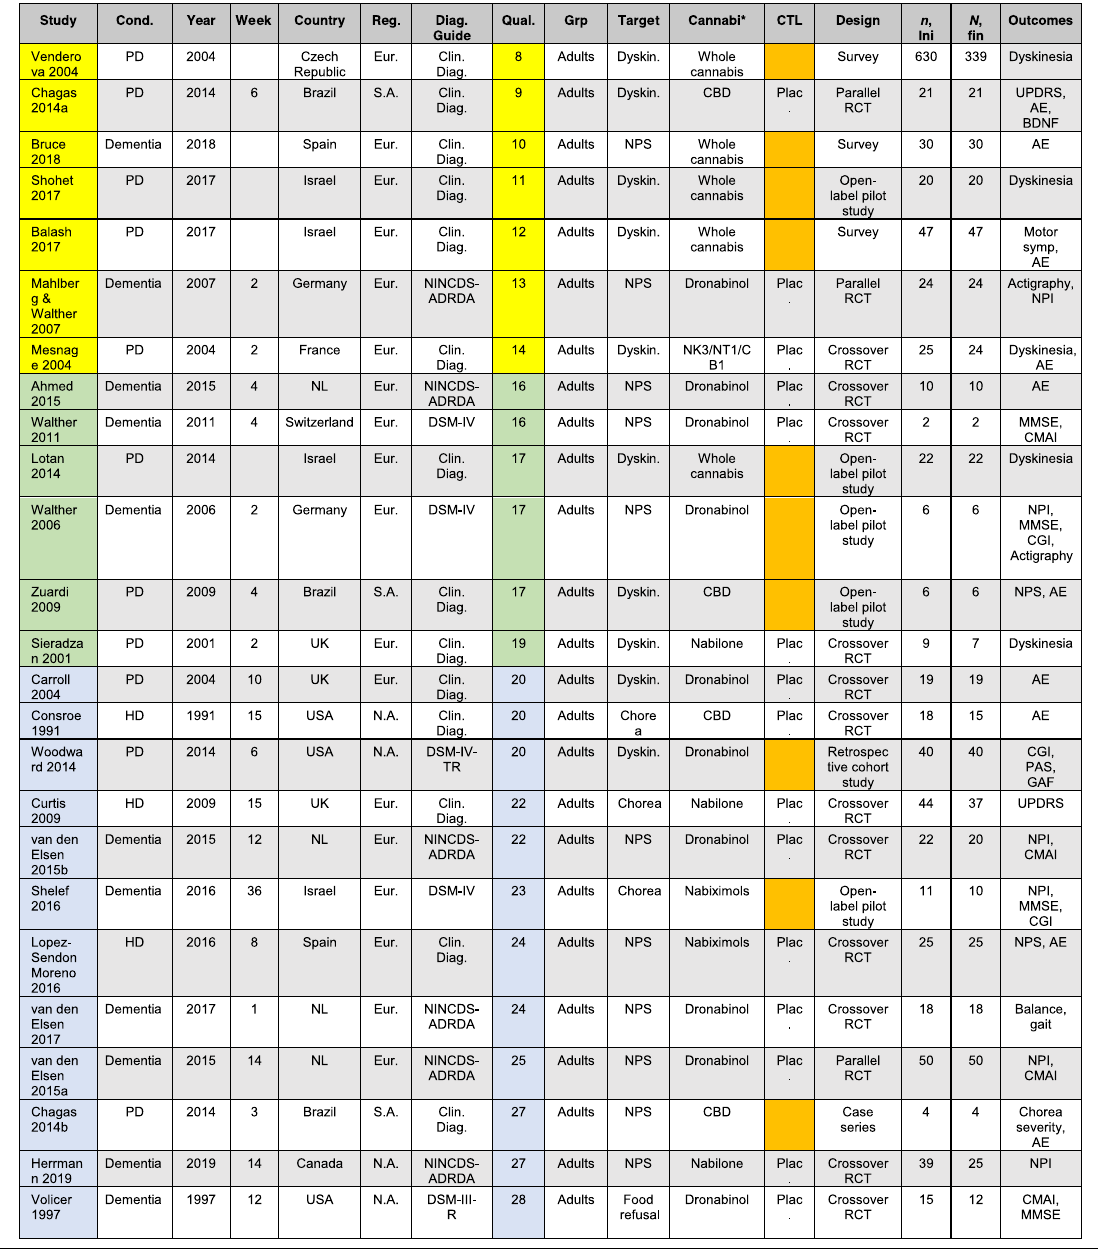
Table 5 Summary of study parameters (alternative order based on quality